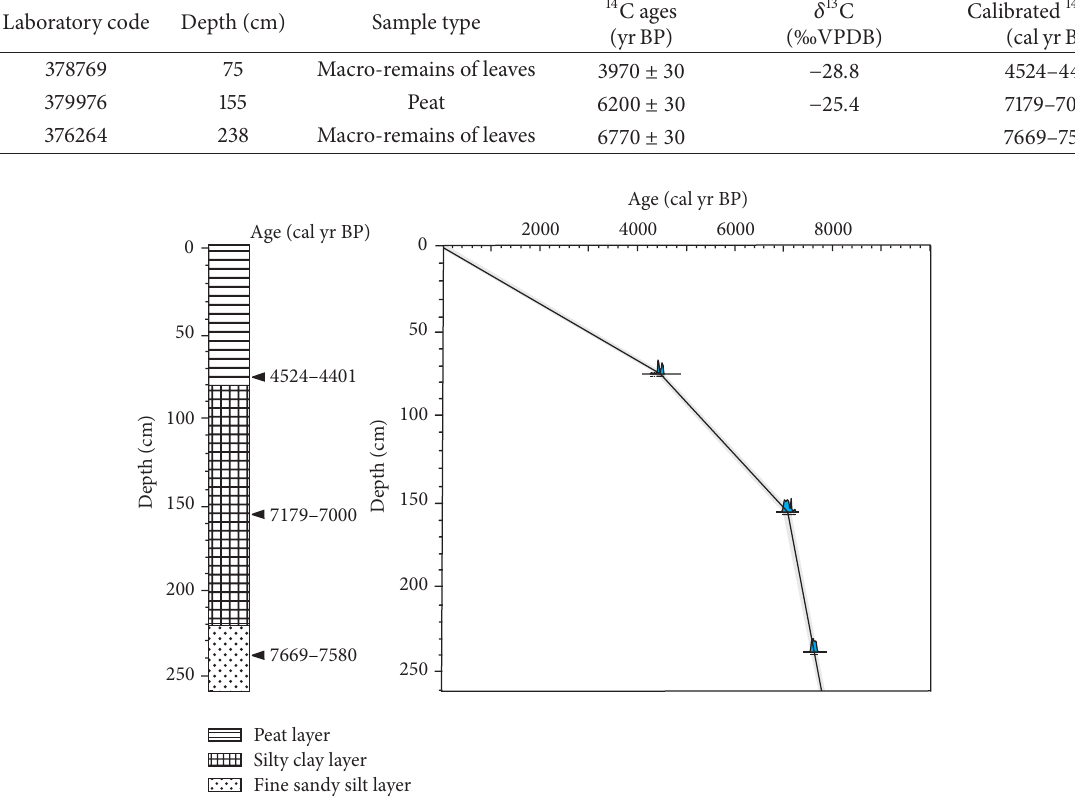
Figure 2: Beihong Section and age-depth